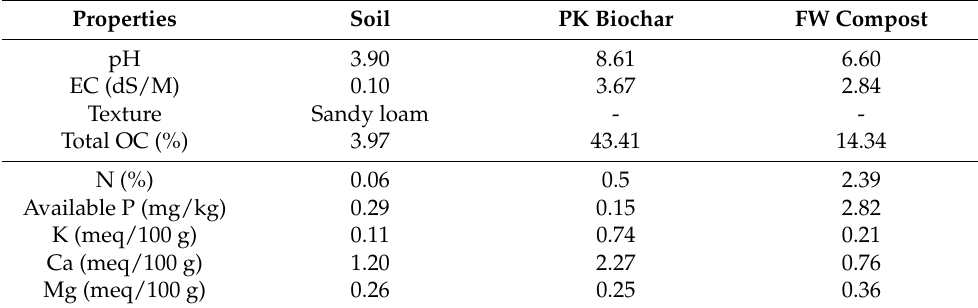
Table 7. Physico-chemical properties of soil and organic fertilizers used in the study. Properties Soil PK Biochar FW Compost pH 3.90 8.61 6.60 EC (dS/M) 0.10 3.67 2.84 Texture Sandy loam - - Total OC (%) 3.97 43.41 14.34 N (%) 0.06 0.5 2.39 Available P (mg/kg) 0.29